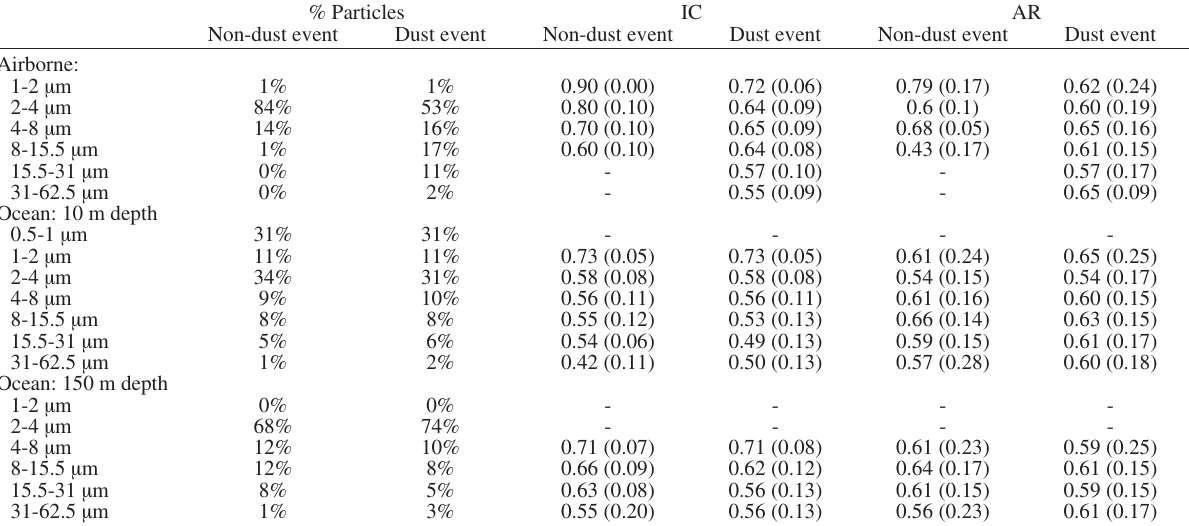
Table 5. – Morphometry of each type of sample during dust and non-dust events. Mean values and standard deviation (between brackets) of the elongation (AR) and irregularity (IC)